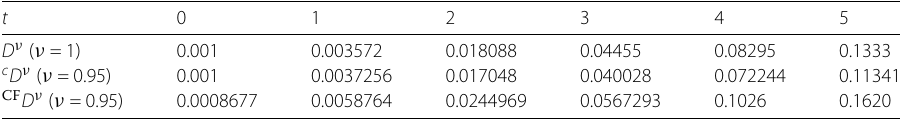
Table 3 Results of three types of derivative: ordinary derivative D ν , Caputo fractional derivative c D ν , and Caputo–Fabrizio fractional derivative CF D ν for V ( t